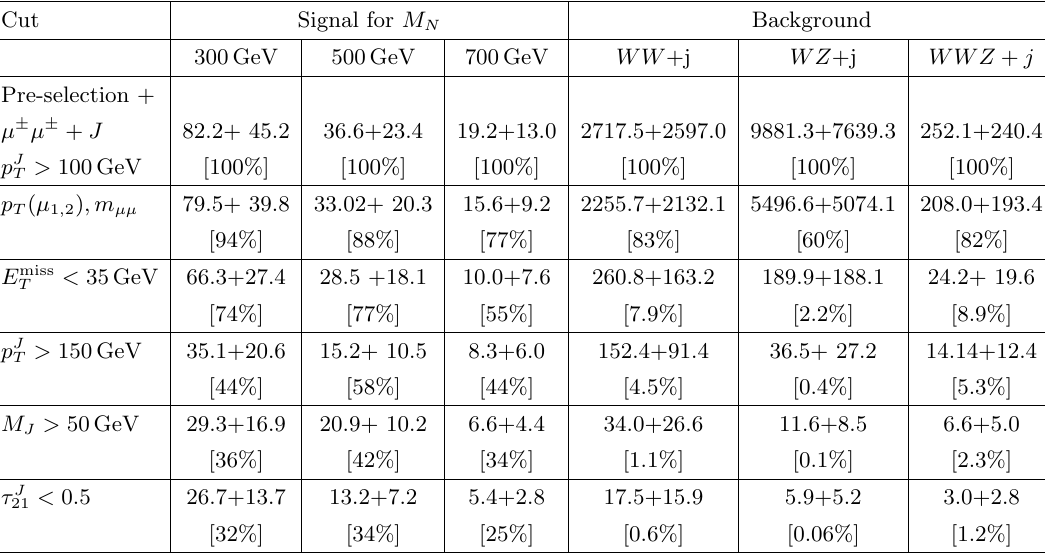
Table 1 . The e(cid:11)ectiveness of di(cid:11)erent variables in minimizing backgrounds is illustrated in the form a cut (cid:13)ow. The two numbers correspond to expected events in (cid:22) + (cid:22) + and (cid:22) (cid:0) (cid:22) (cid:0) channels. We adopt a typical mixing angle V (cid:22)N = 0 : 03. The numbers are for an integrated luminosity of j j 3000fb (cid:0) 1 , at the 13 TeV